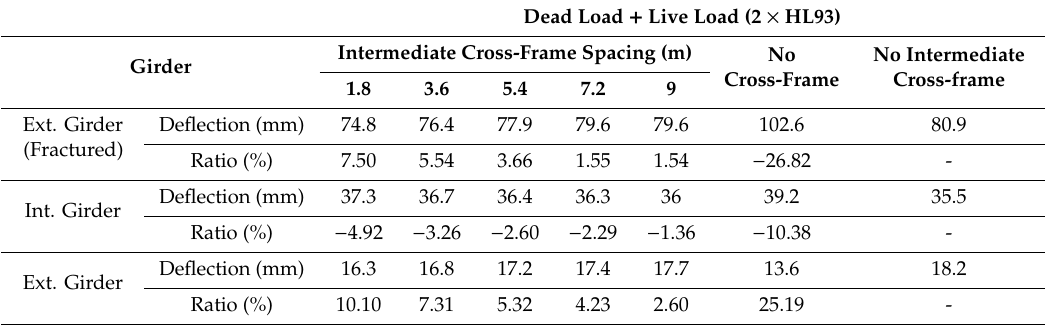
Table 1. Girder deflection at mid-span under the dead and 2 times HL93